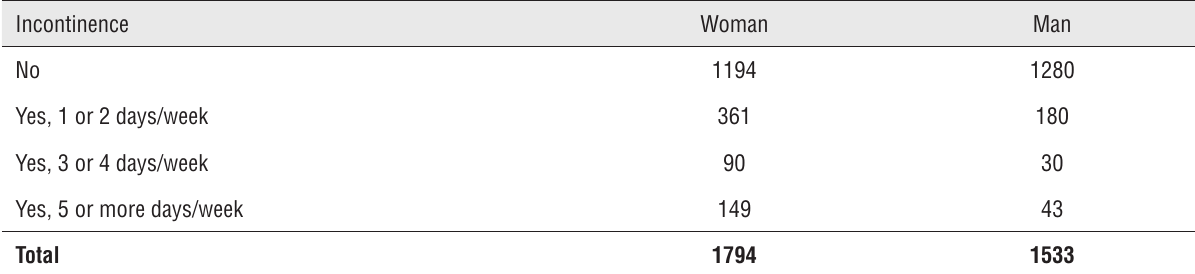
Table 3 - Prevalence of urinary incontinence.